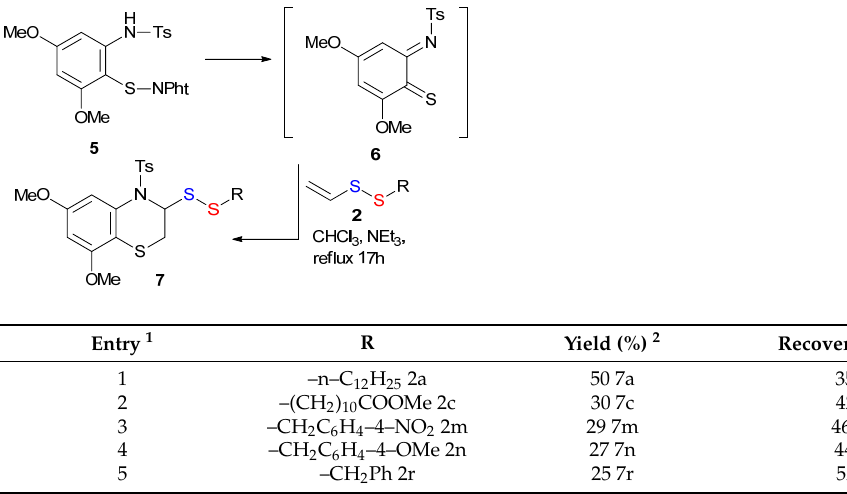
Materials 2021 , 14 , Table 3. Synthesis of benzo[ b ][1,4]thiazine disulfanyl derivatives 7 .